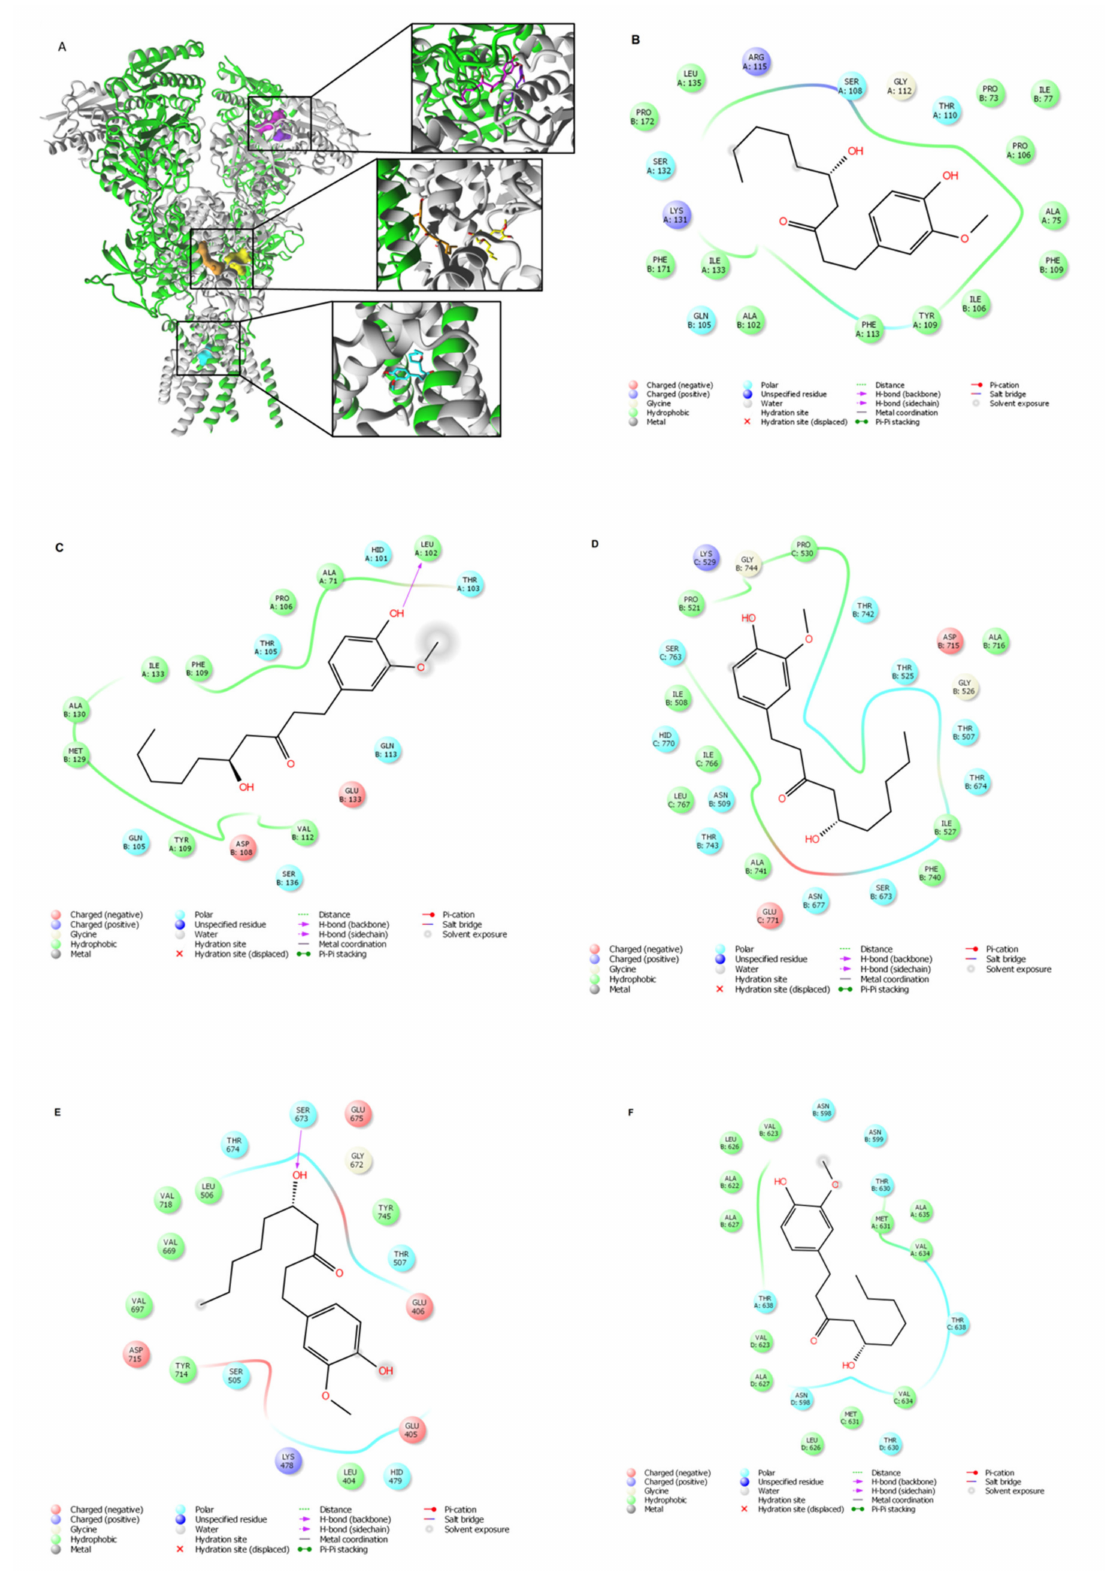
Figure 8. Molecular docking of 6-GIN to the GluN1/GluN2B NMDA receptor. ( A ) 6-GIN binding sites (surface model) are located at the ATD (magenta and purple), the LBD (yellow and orange) and the TMD (cyan) of the GluN1/GluN2B